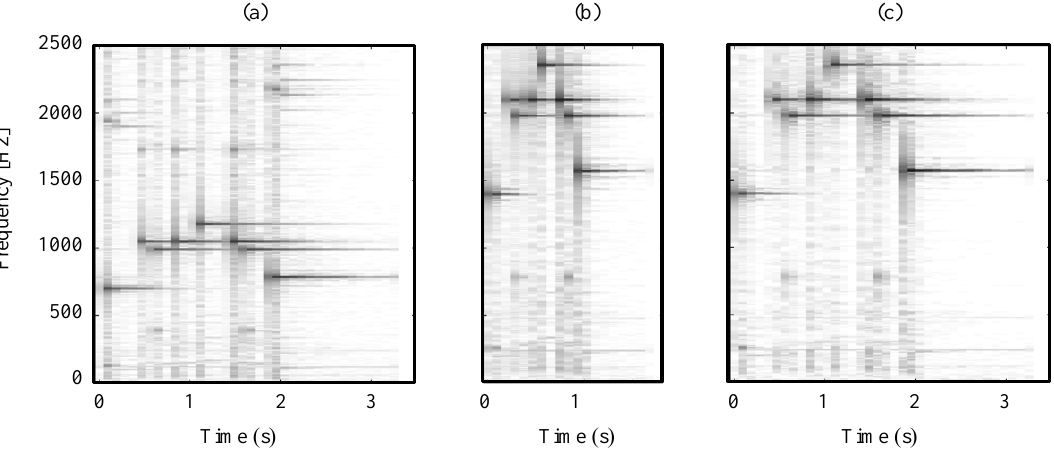
Figure 16. Pitch-shifting via resampling and TSM. ( a ) Spectrogram of an input audio signal; ( b ) Spectrogram of the resampled signal; ( c ) Spectrogram after TSM